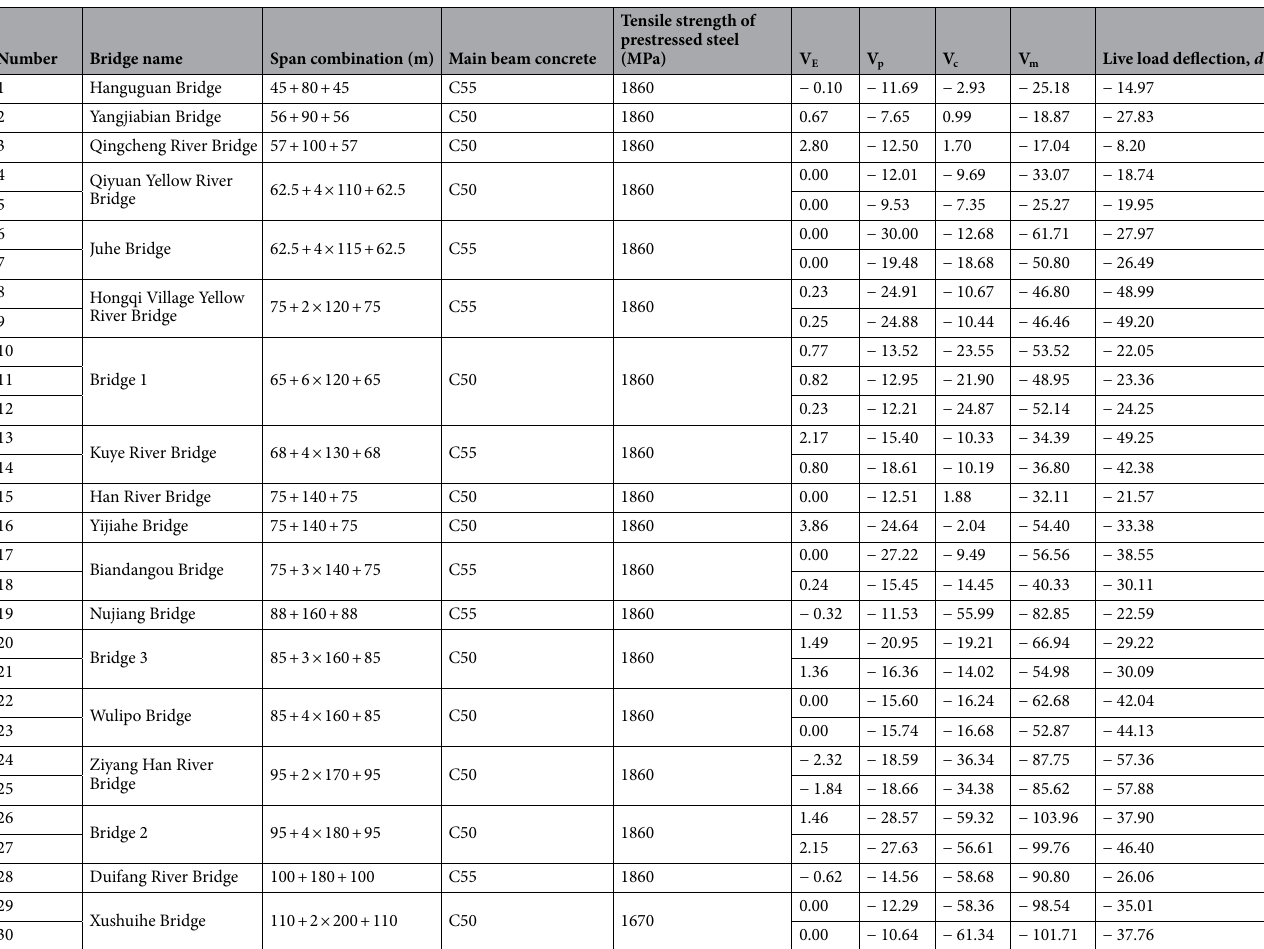
Table 2. Finite element calculation results (mm).